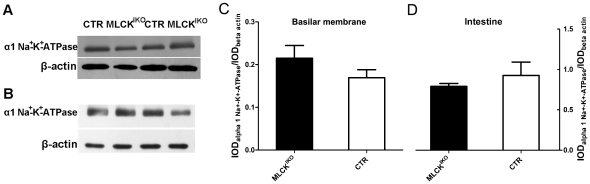
Expression of the Na+-K+-ATPase protein.(A, C) The apical turns of the basilar membrane were isolated from 10-week-old MLCKIKO and CTR mice and subjected to western blotting to analyze Na+-K+-ATPase protein expression. (B, D) Smooth muscle from ileum segments of Mlck
SMKO mice (28) was isolated and subjected to western blotting to analyze Na+-K+-ATPase protein expression. Quantitative analysis was performed by measuring the relative density of the bands. The bars represent the means of IODα1 Na + - K+-ATPase/IODβactin ± S.E. (Fig B: P>0.05 vs CTR; Fig D: P>0.05 vs CTR).